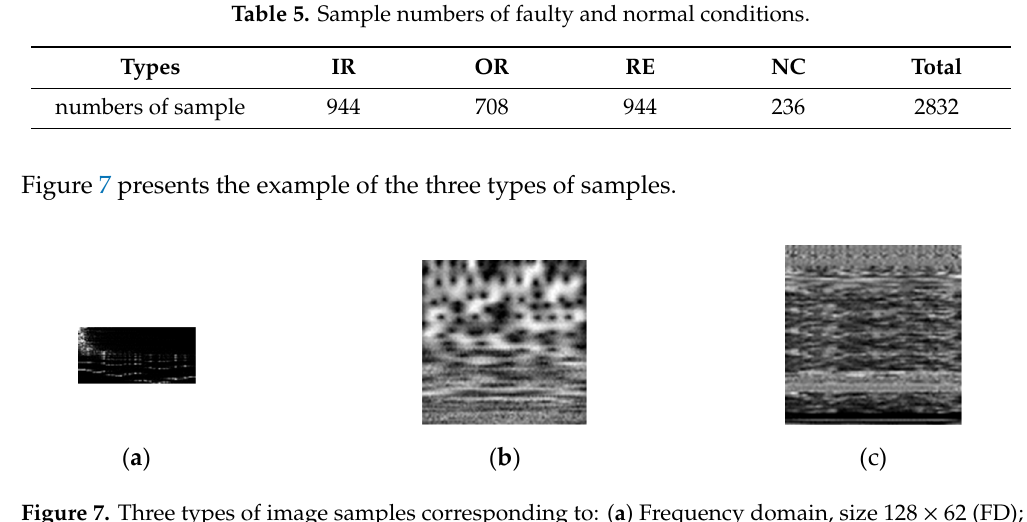
Figure 8. The final structure and related parameters of FD-Net. The fault diagnosis performance of a DCNN and corresponding Ada-DCNN are compared under four accuracy levels as in Table 6, and the accuracy of DCNNs, as well as the improvements by Ada-DCNNs in four levels, are shown in Figure 9a.